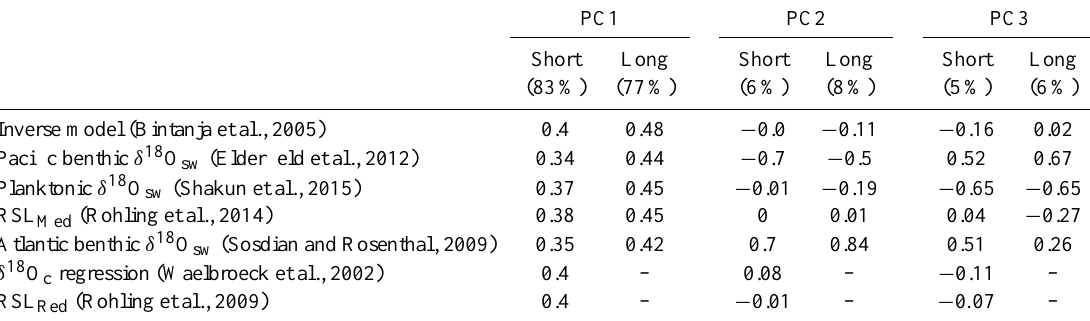
Table 1. Principal component analysis (PCA) loading for each proxy record. “Short” refers to the 0–430ka time window, and “Long” refers to 0–798ka. Numbers in parentheses give the percent variance explained by each principal component. PC1 PC2 PC3